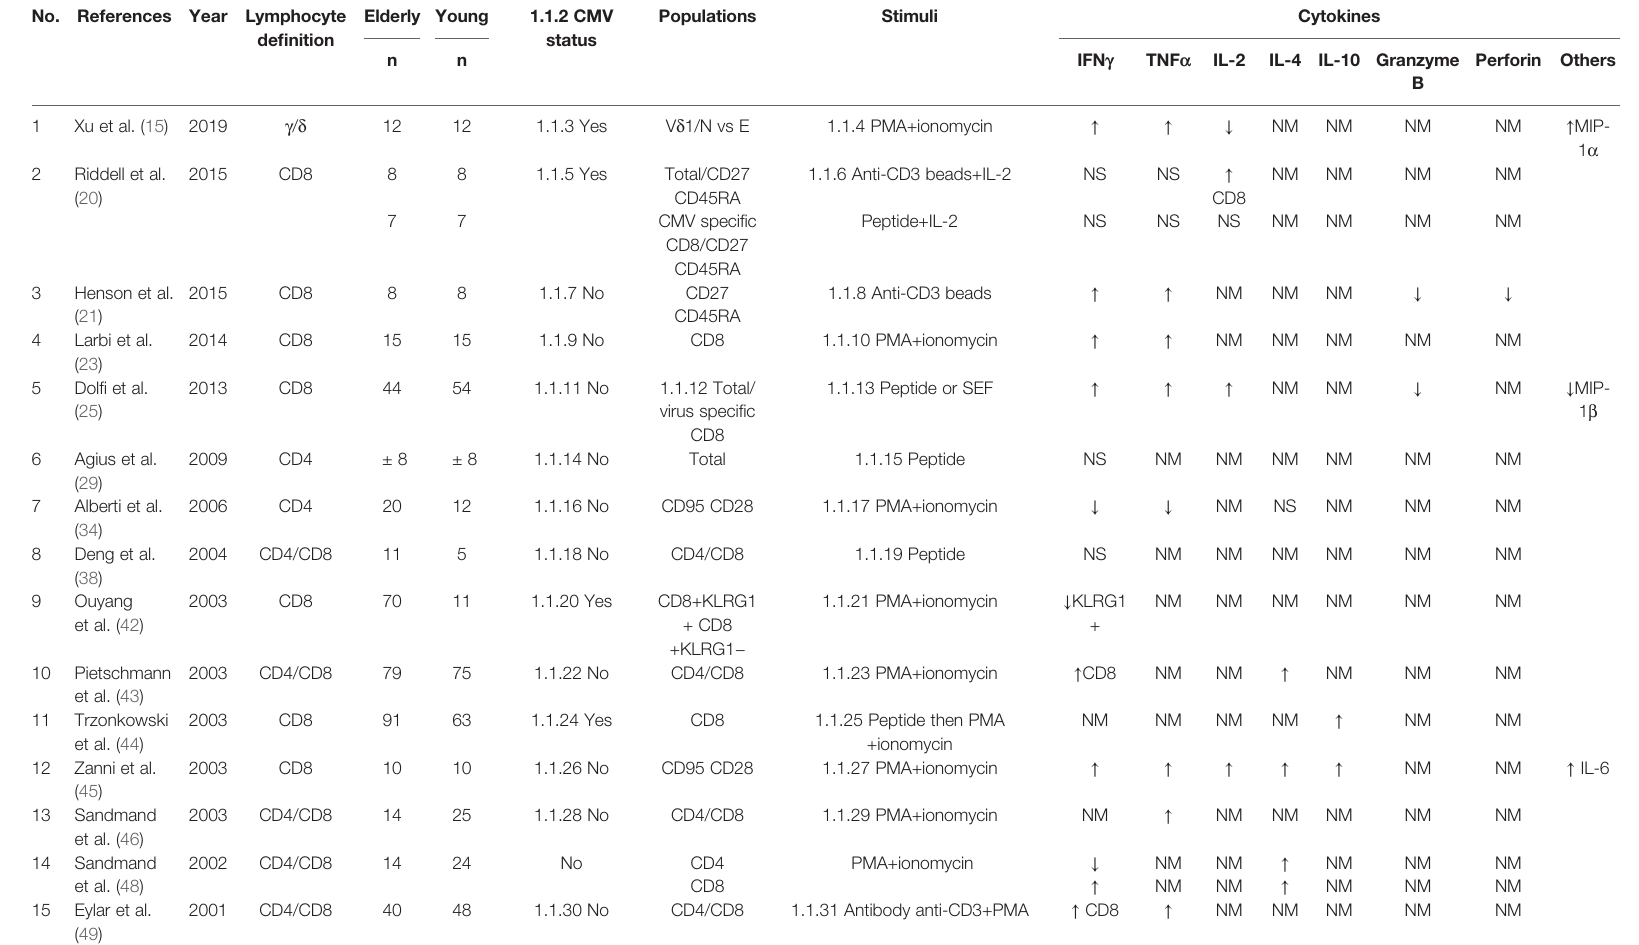
TABLE 3 | Characteristics of studies reporting